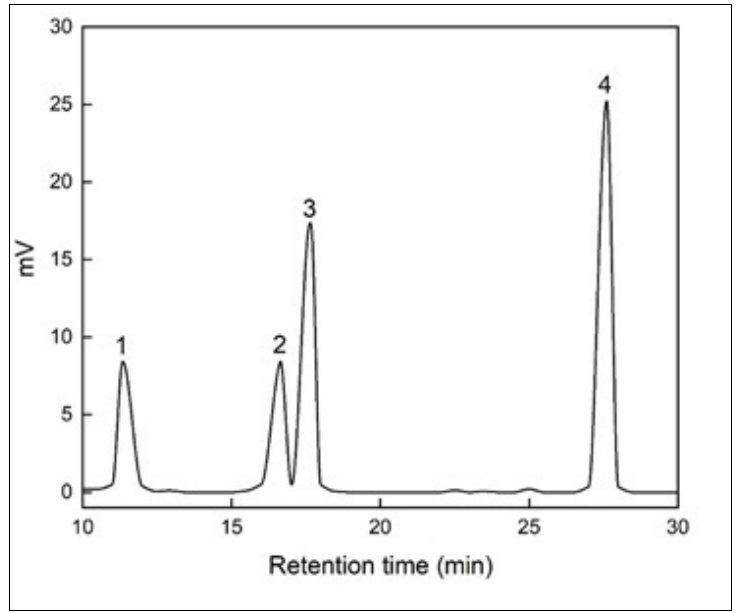
Figure 3. The monosaccharides composition of the analyzed sample: 1. rhamnose; 2. galacturonic